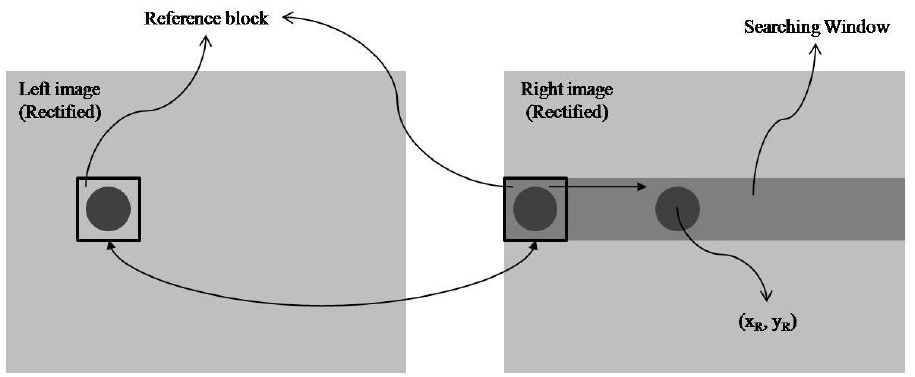
Figure 11. The stereo